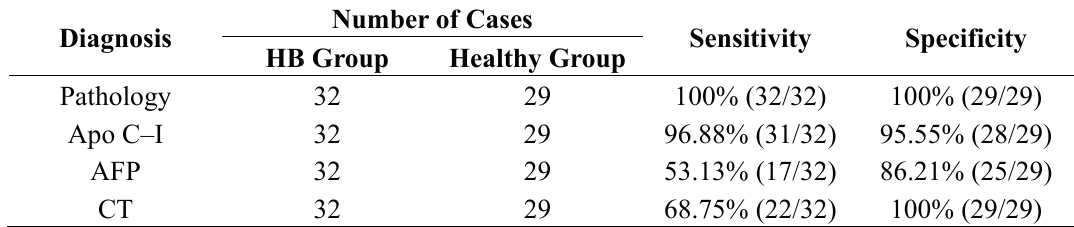
Table 5. Sensitivity and specificity of various diagnosis methods between HB and healthy